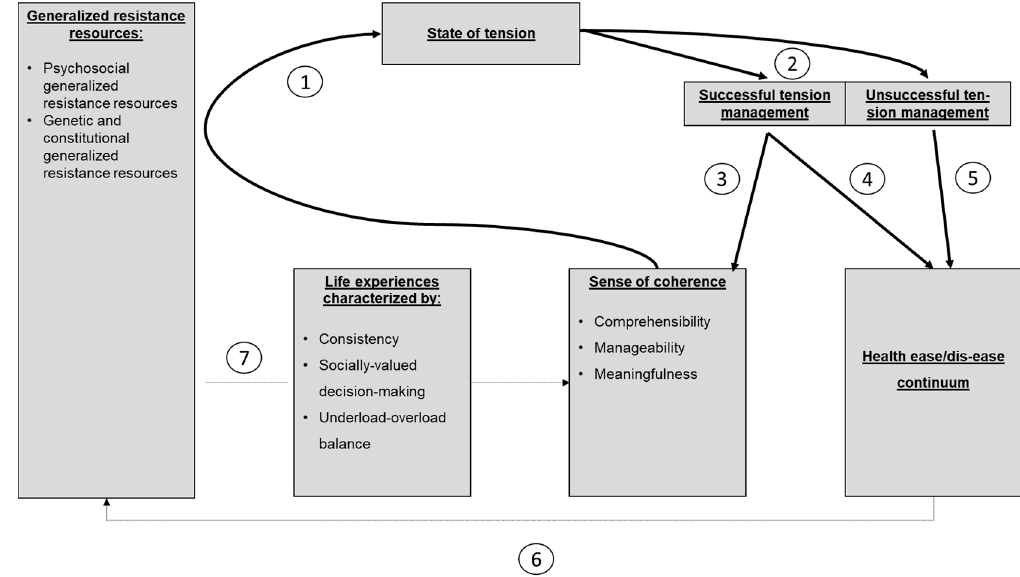
Figure 1. A simplified reproduction of the salutogenic model [17] (p. 871). (with the permission of the author).